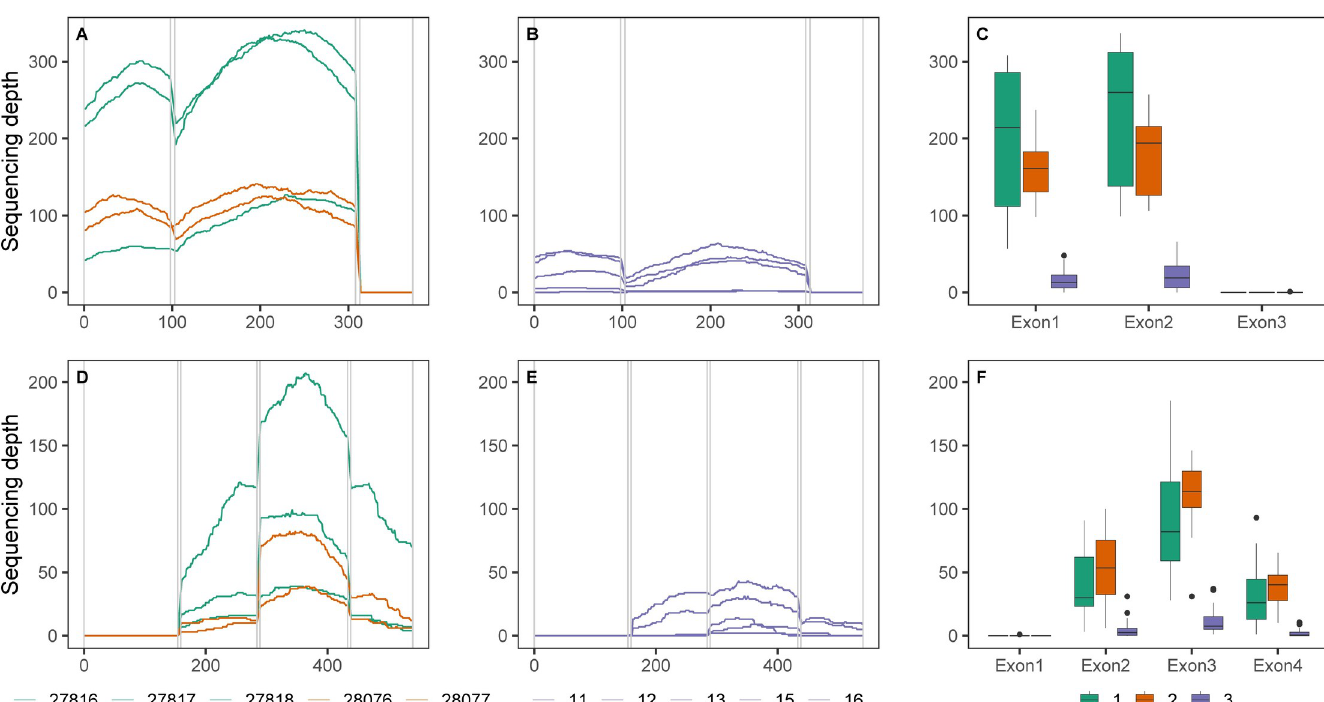
Fig 2. Example plots of sequencing depth per base across orthologous groups (OGs): EOG54MW8B (3 exons; upper row A–C) and EOG54MW7V (4 exons; lower row D–F). Examples from run 1 (includes sequenced libraries: 27816, 27817, 27818) and run 2 (sequenced libraries: 28076, 28077) are given in A and D, and from run 3 (sequenced libraries: 11, 12, 13, 15, 16) in B and E. Introns are delineated by vertical lines in A, B, D and E. Boxplots in C and F highlight the distribution of sequencing depth for each exon within the OG grouped by the three different sequencing runs. Run 1 is indicated in green, run 2 in orange, and run 3 in purple. Horizontal lines in C and F are median sequencing depths, vertical lines show boxplot whiskers, and solid points represent outliers.